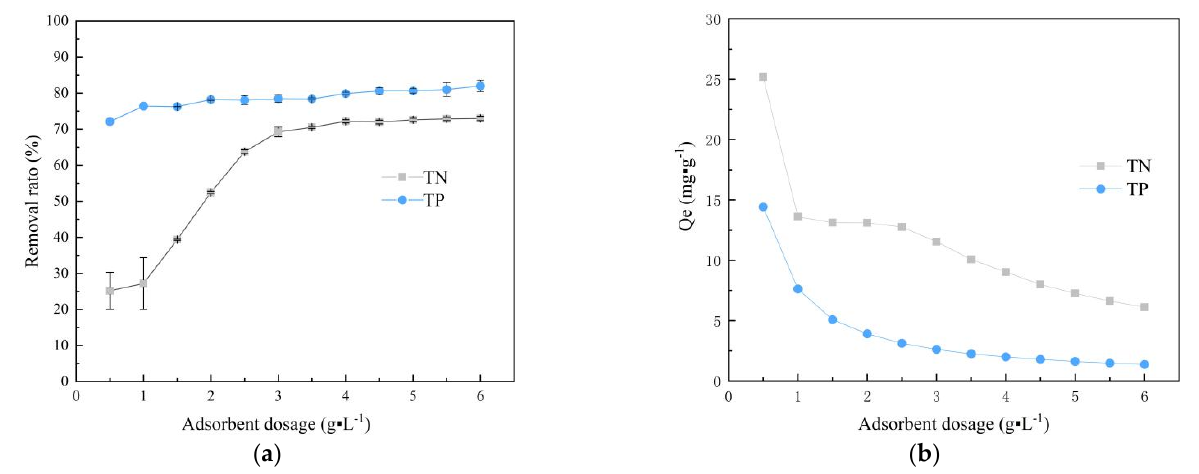
Figure 5. Effect of SOD dosage on simultaneous ammonium and phosphorus removal. ( a ) Change graph of removal rate with increase in dosage, ( b ) change graph of unit adsorption capacity with increasing dosage (C P0 = 10 mg/L; C N0 = 50 mg/L; pH = 7.0; T = 25 °C; t = 90 min).